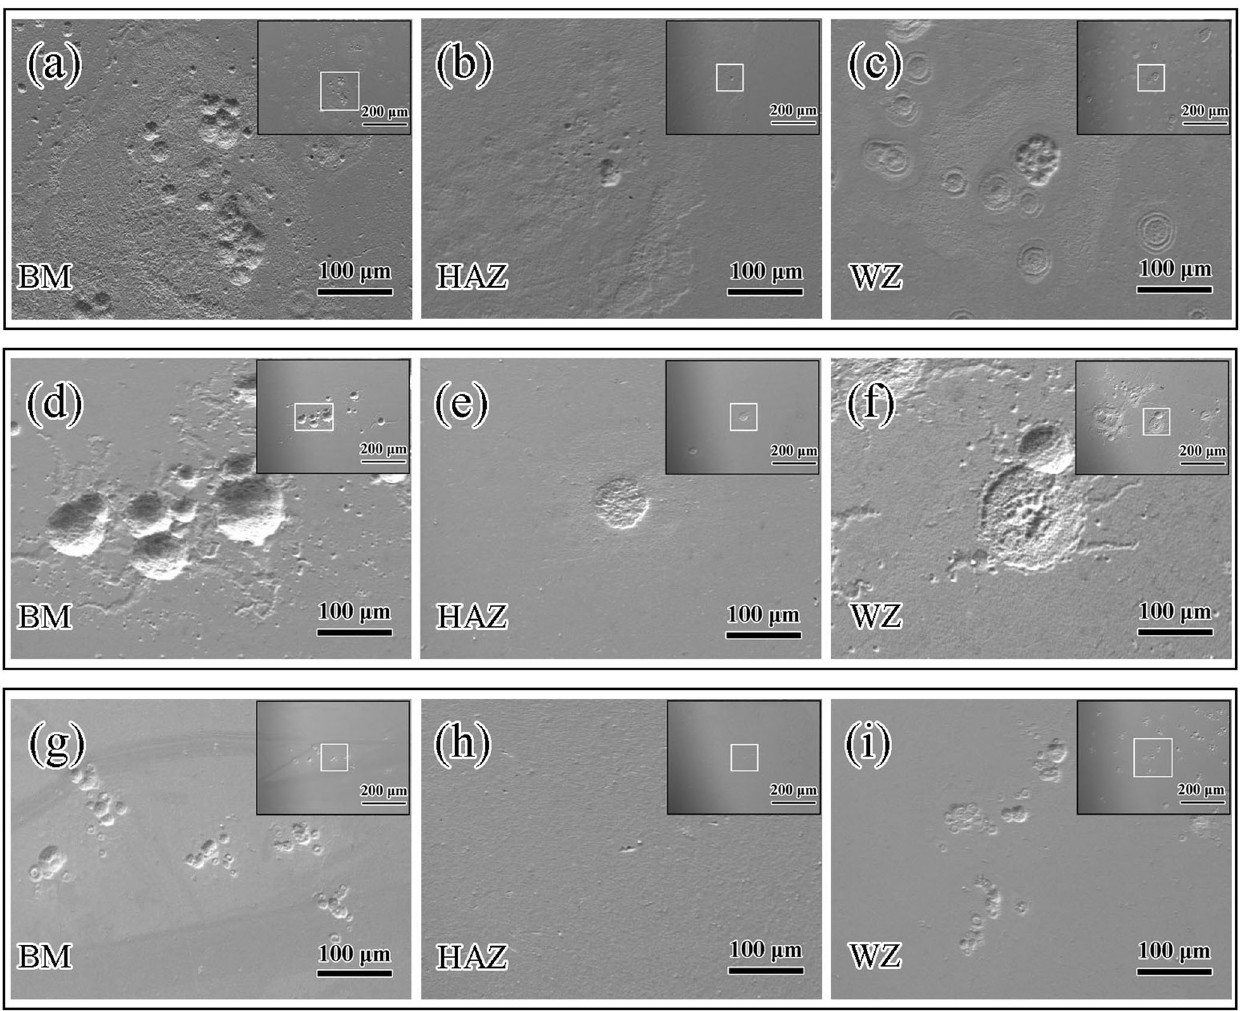
Fig. 5 Corrosion morphology of welded joints after 30 d immersion. a – c Show the corrosion morphology of BM, HAZ, and WZ zones after 30 d immersion in the medium with 0% organic carbon sources level. d – f Show the corrosion morphology of BM, HAZ, and WZ zones after 30 d immersion in the medium with 1% organic carbon sources level. g – i Show the corrosion morphology of BM, HAZ and WZ zones after 30 d immersion in the medium with 100% organic carbon sources